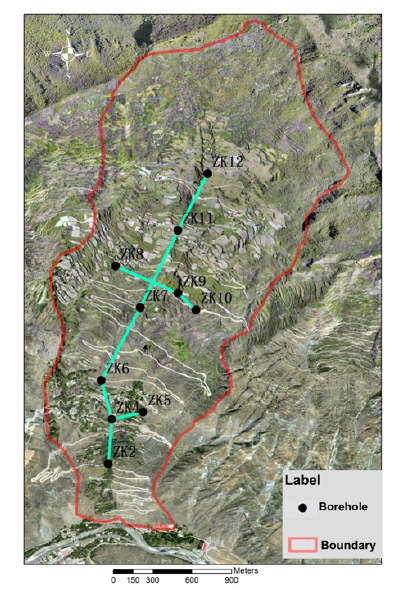
Figure 2. Spatial distributions of diverse boreholes on